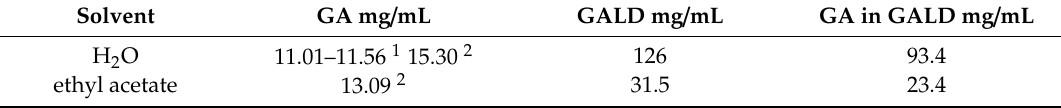
Table 3. Comparison between solubility (mg / mL) of GA, GALD, and GA in GALD in water and AcOEt.